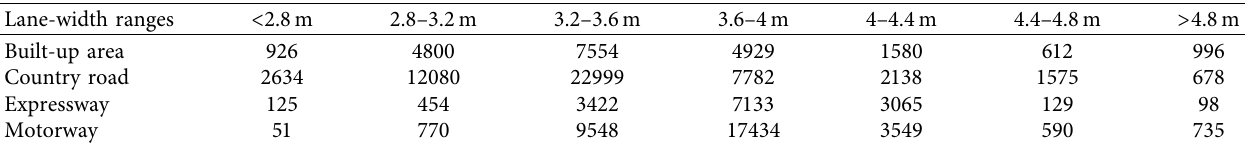
Table 2: The number of lane-width occurrences—measured and counted at equidistant discrete path lengths—within each lane-width range, or “bin,” computed for the chains of compound sequences used for training.